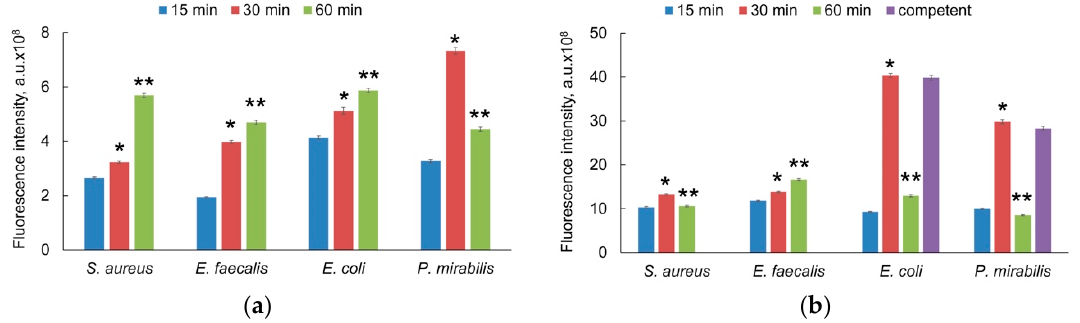
Figure 5. Accumulation of Fotoditazin at 5 µg/mL ( a ) and 50 µg/mL ( b ) of final concentration by Gram-positive and Gram-negative bacterial strains for 15 min, 30 min, and 60 min. Statistically significant differences between 15 min (*) and 30 min (**) are marked.